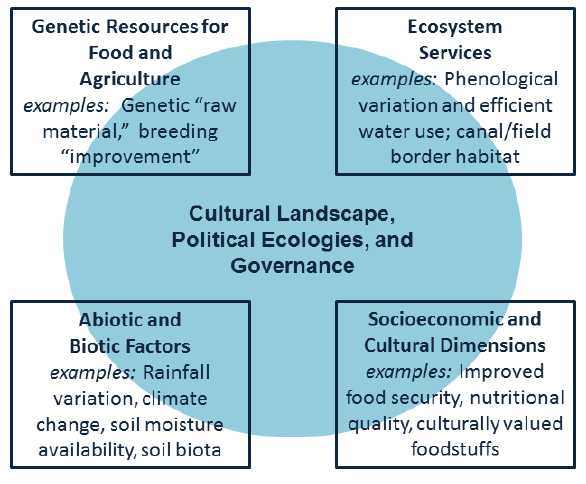
Fig. 1 . Cultural landscapes in relation to the major components of agrobiodiversity as defined in the Convention on Biological Diversity, with examples and conceptual framework from this